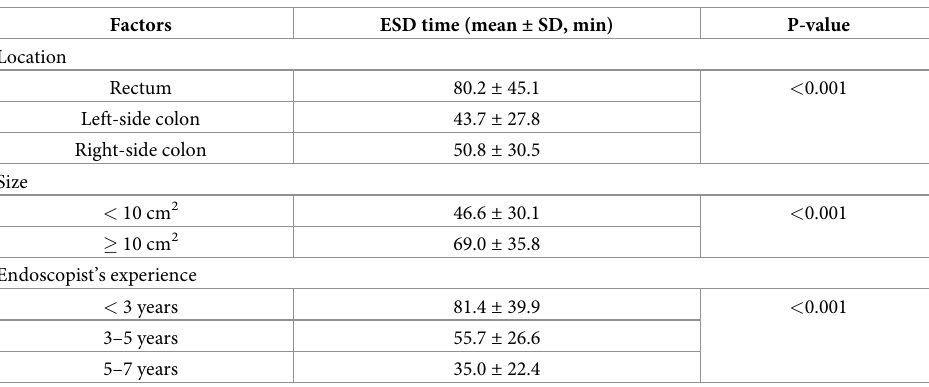
Table 3. Analysis of the efficiency of